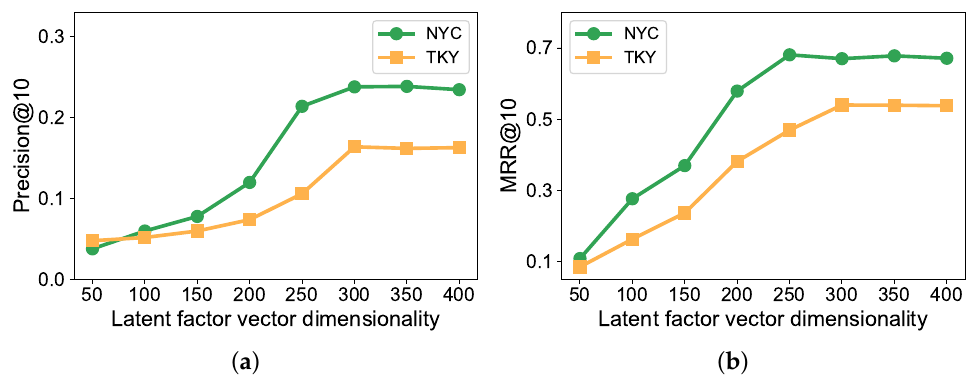
Figure 13. Performance of different latent factor vector dimensionality (top-10 recommendations): ( a ) Precision; ( b )